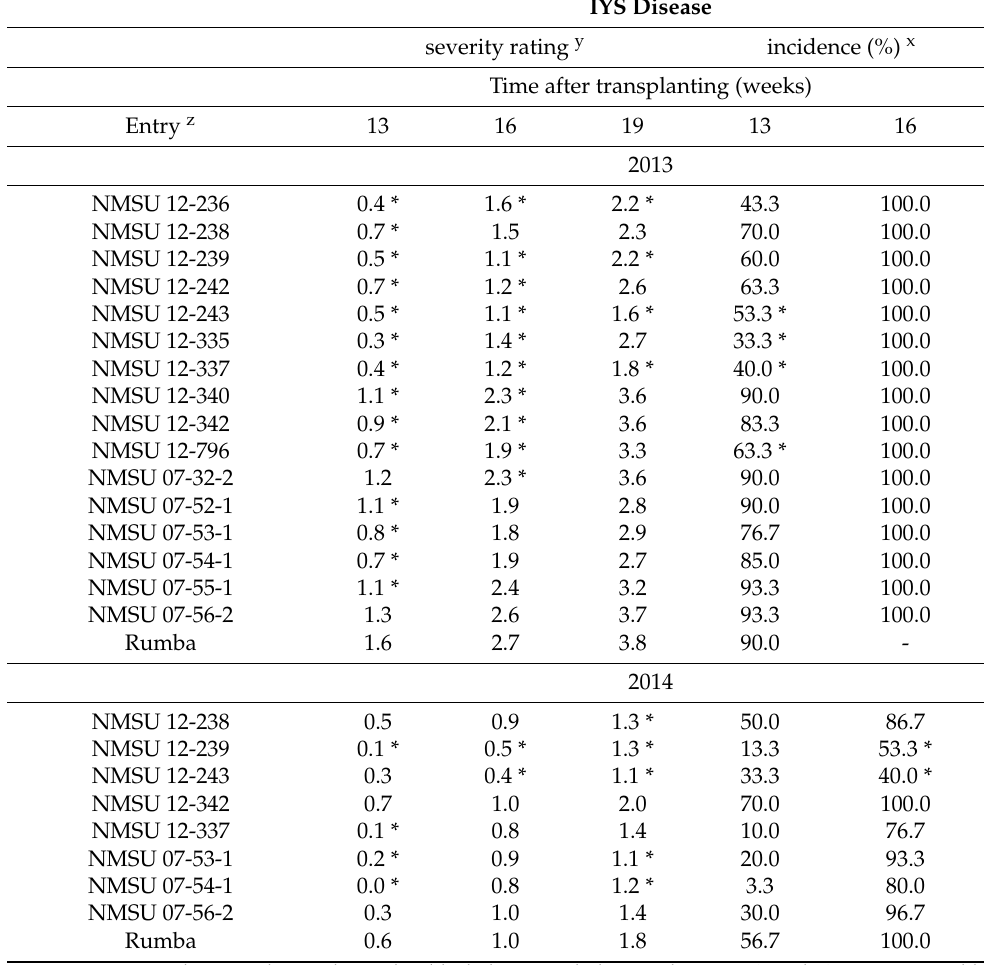
Table 3. Mean values and comparisons of selected lines with susceptible check ‘Rumba’ for Iris yellow spot (IYS) severity rating and incidence measured several times throughout the 2013 and 2014 growing seasons at the Leyendecker Plant Science Research Center in Las Cruces, New Mexico, USA. IYS